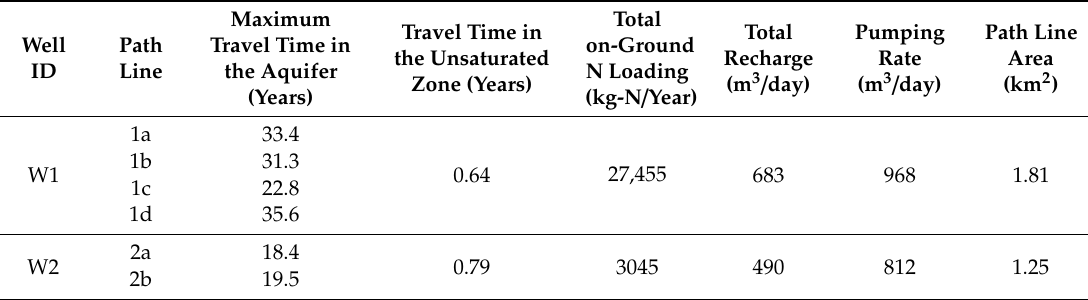
Table 7. Summary of the data related to wells W1 and W2 (see Figure